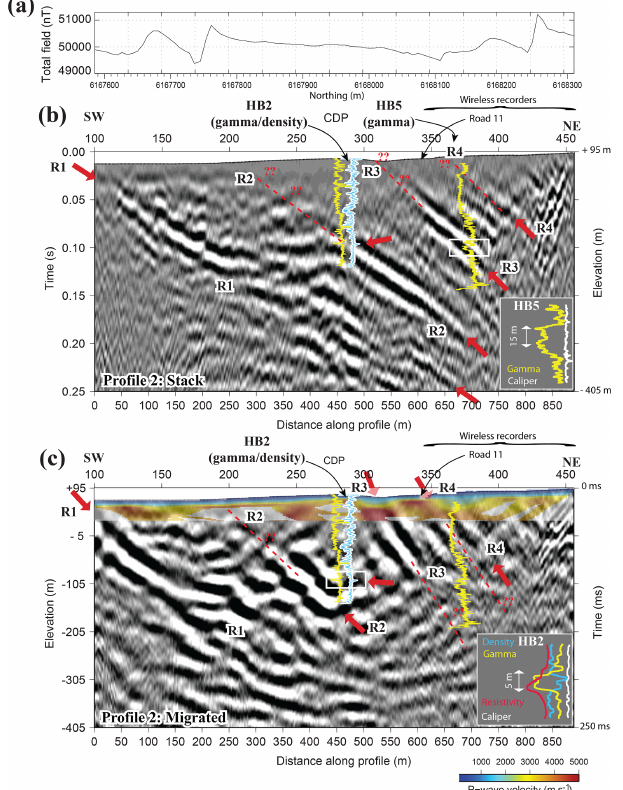
Figure 11. (a) Ground total-field magnetic, (b) unmigrated and (c) migrated (also time-to-depth-converted) reflection seismic sec- tions along profile 3. The tomographic velocity model is projected onto the migrated section for direct comparison. Red arrows mark the reflections. They may extend at depth but we are unable to im- age them due to the short length of the profile. Downhole logging results from borehole HB3 suggest that the reflection R2 is associ- ated with the zone of reduced natural gamma. The caliper log sug- gests no change in the borehole diameter. Based on these, we argue that the reflection originated from a dolerite